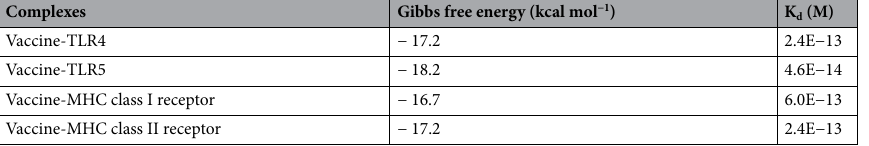
Table 9. The PRODIGY server predicted the binding affinities of the docked complexes with vaccines and TLR4, TLR5, MHC I receptor, and MHC II receptor.